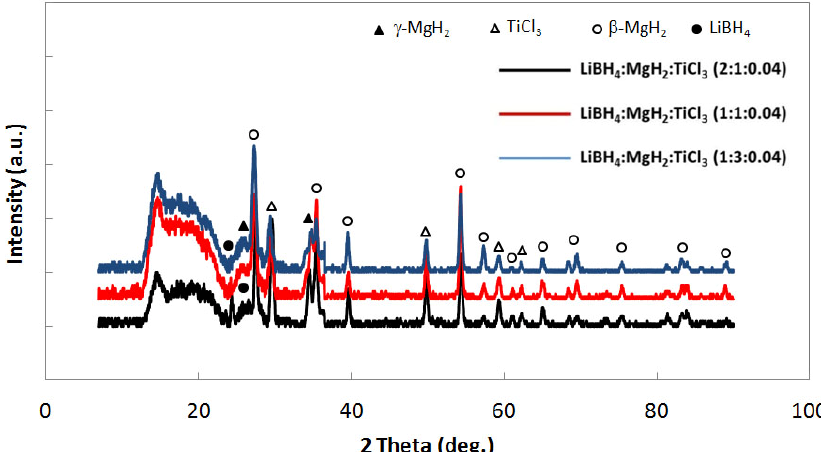
Figure 8. X-ray diffraction for 4 mol % TiCl molar